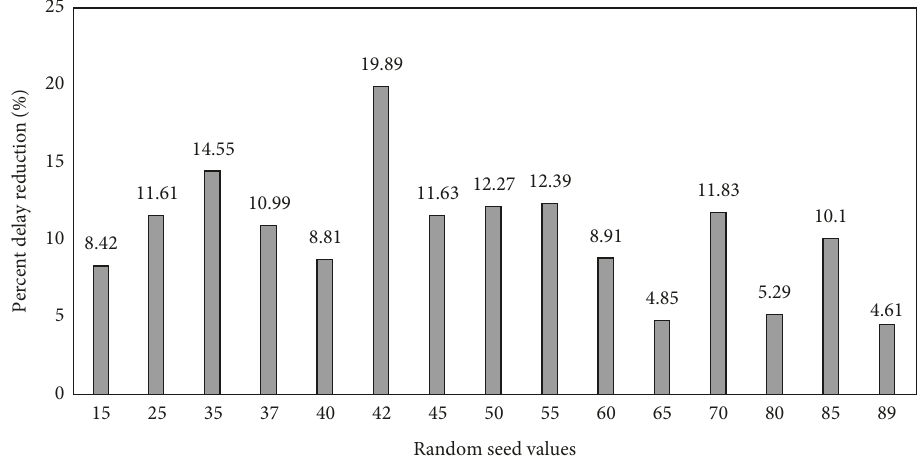
Figure 12: Simulation-based comparison of intersection delays by Model I and Webster’s design across different random